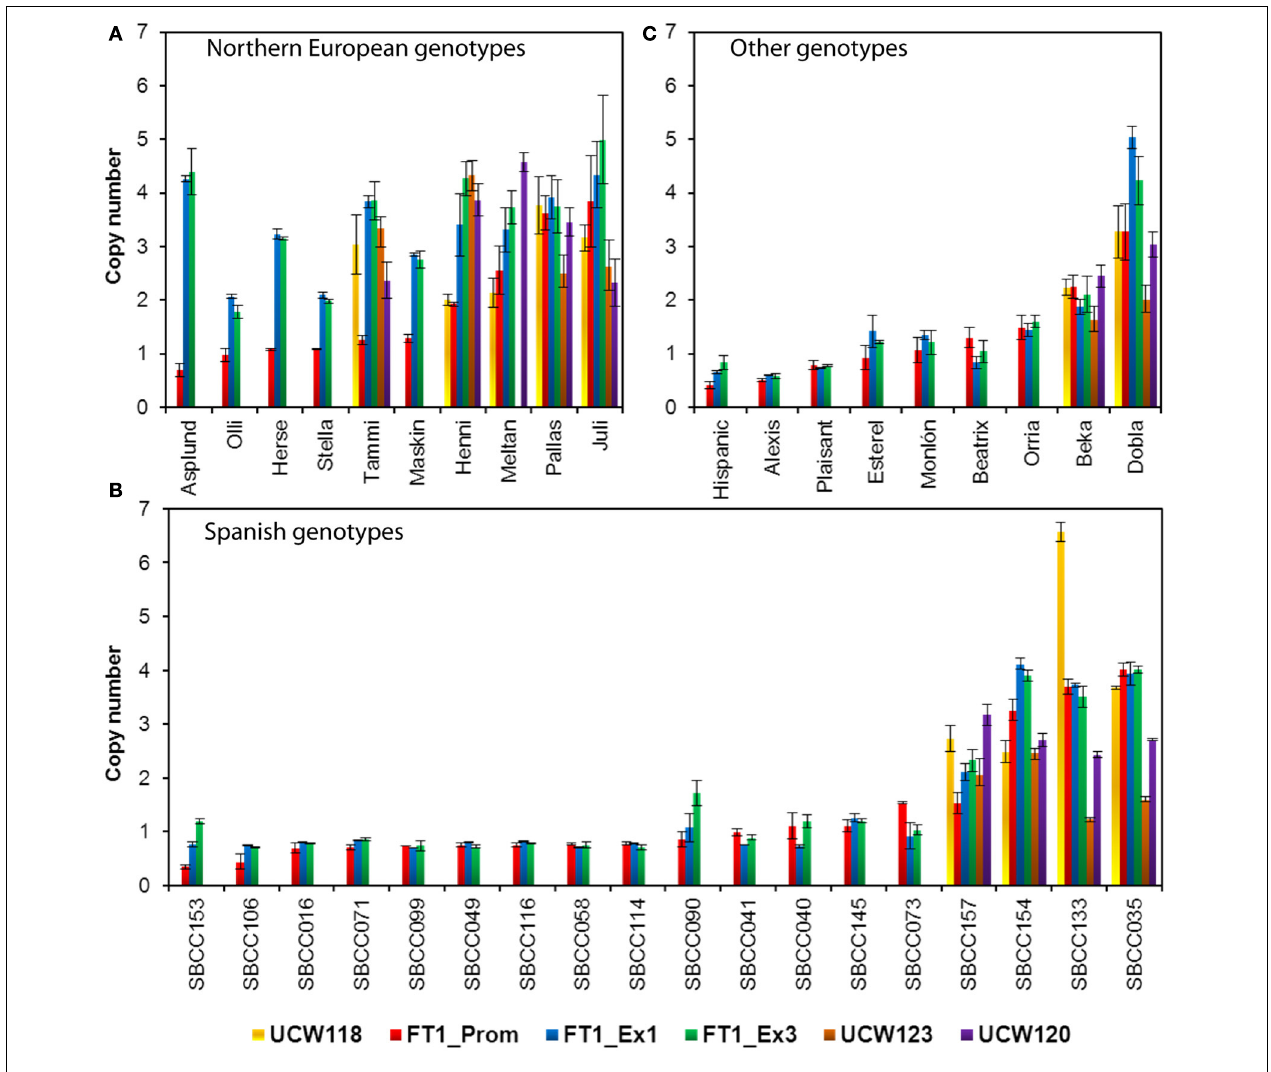
FIGURE 2 | Analysis of copy number variation for HvFT1 (promoter, exon 1, and exon 3), and for regions upstream ( UCW118 ) or downstream ( UCW123 and UCW120 ) of HvFT1 on barley genotypes of Northern